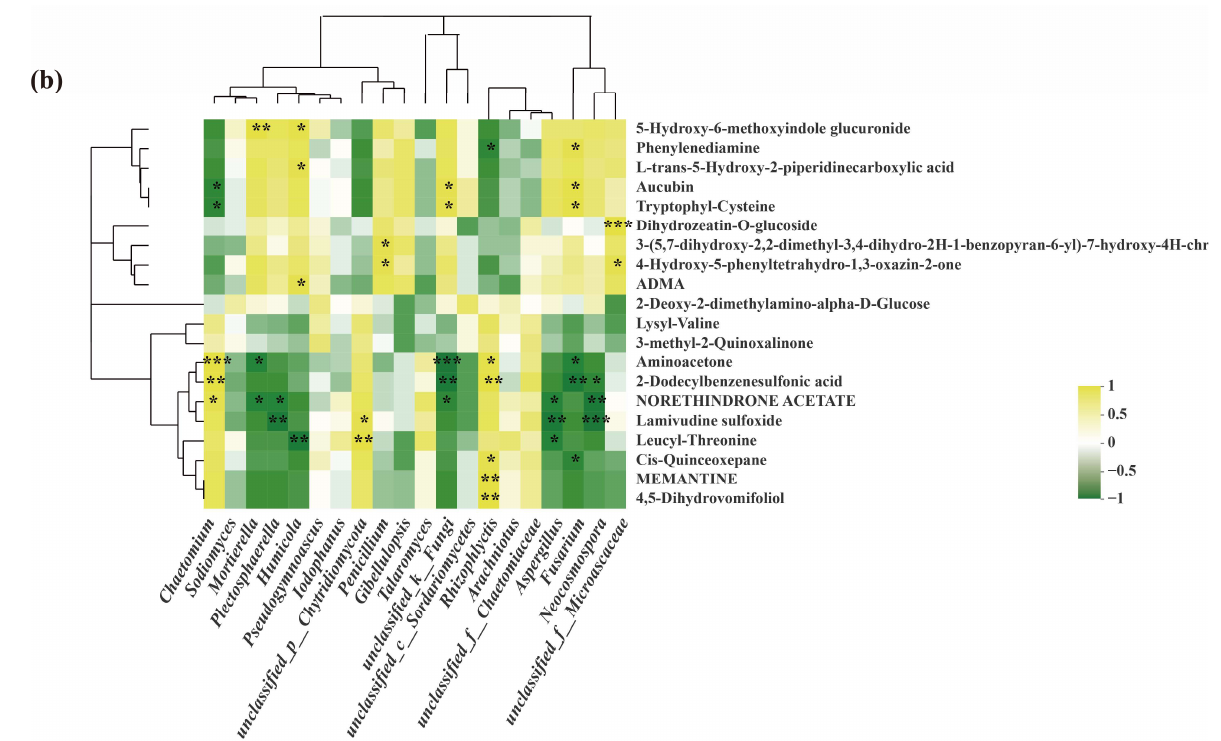
Figure 11. Correlation of metabolites in root exudates and bacterial ( a ) and fungal ( b ) communities in rhizospheres of oilseed rapes under RR and RL systems. Heatmaps analyze the Spearman correlation coefficient (rho value) and p value of metabolites and flora. * 0.01 < p < 0.05, ** 0.001 < p < 0.01, *** p < 0.001. This indicates that the difference is significant. The clustering at the top and left of the graph shows the metabolites of the bacterial groups and the results of hierarchical clustering based on Euclidean distance,